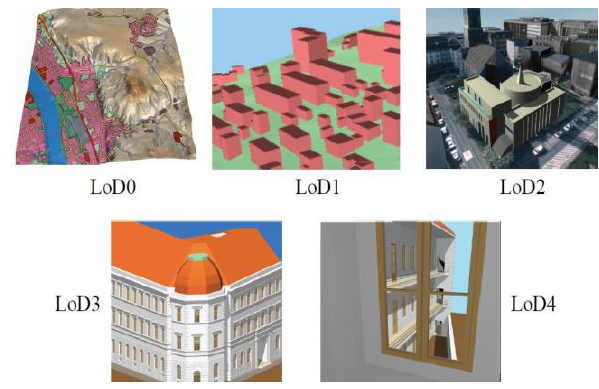
Figure 1. LoD representation defined by CityGML (Kolbe et al., 2005).